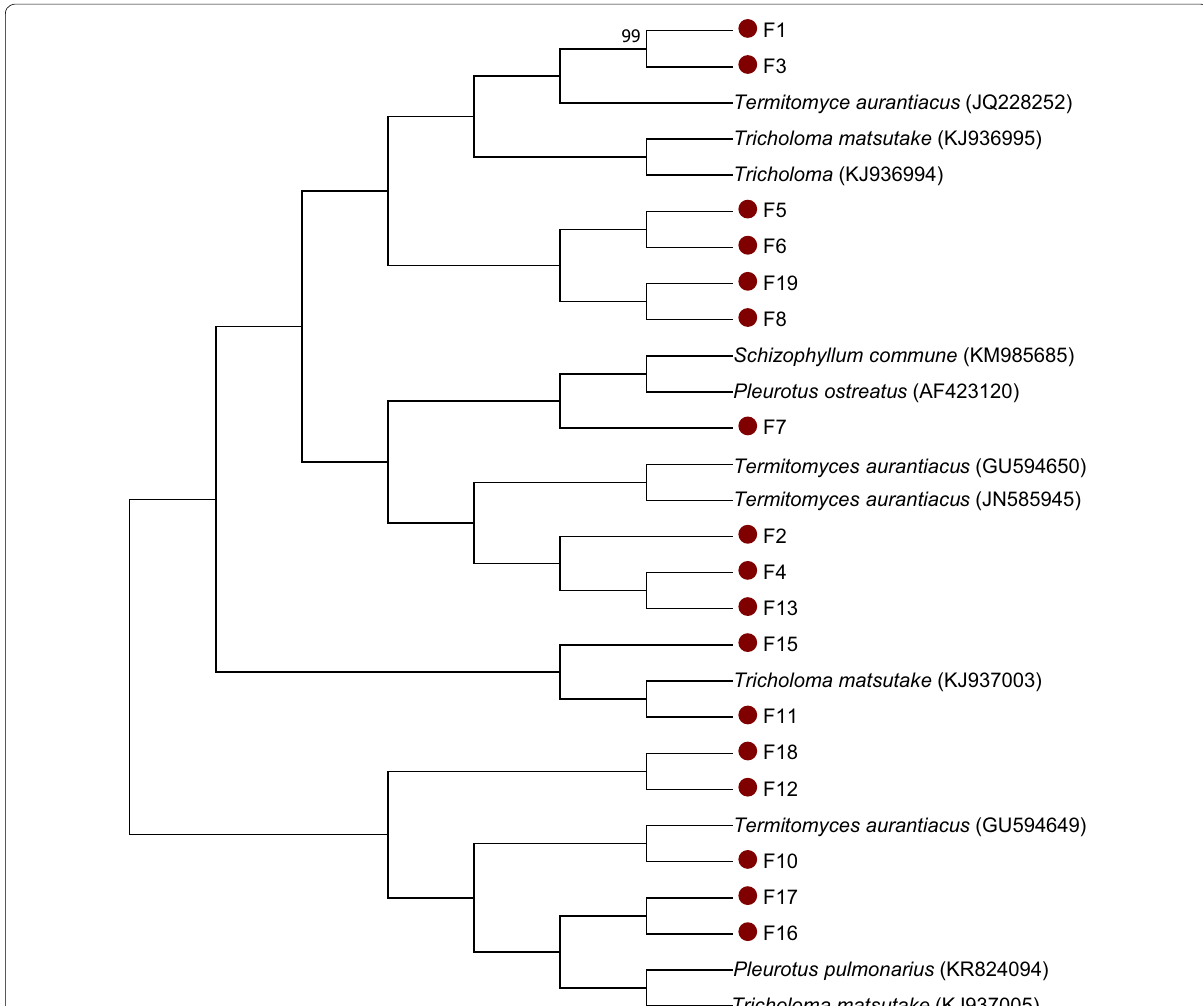
Fig. 3 Phylogenetic analysis based on partial 16S rDNA sequences of 19 wild mushrooms obtained in this study and 11 other reference sequences from the GenBank. The tree was reconstructed using maximum likelihood method as implemented in Mega